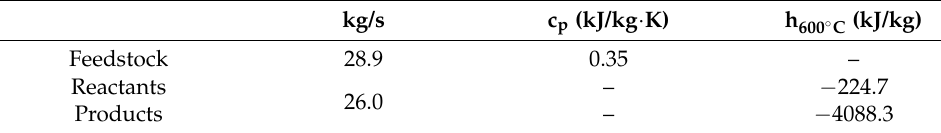
Table 3. Mass flow, specific heat, and enthalpy of pyrolysis